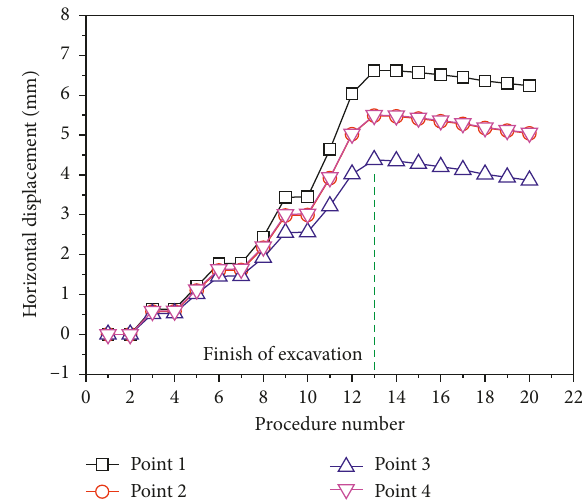
Figure 14: Horizontal displacement of the tunnel structure in scheme